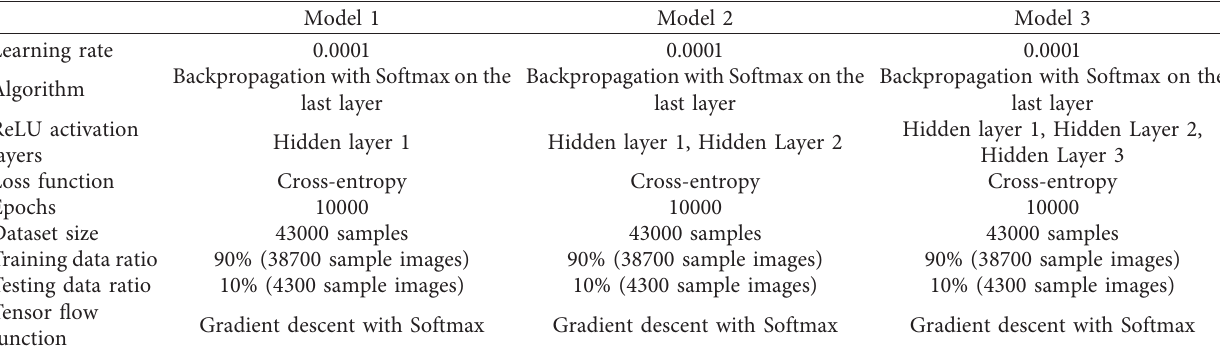
Table 3: Parameters’ details of used